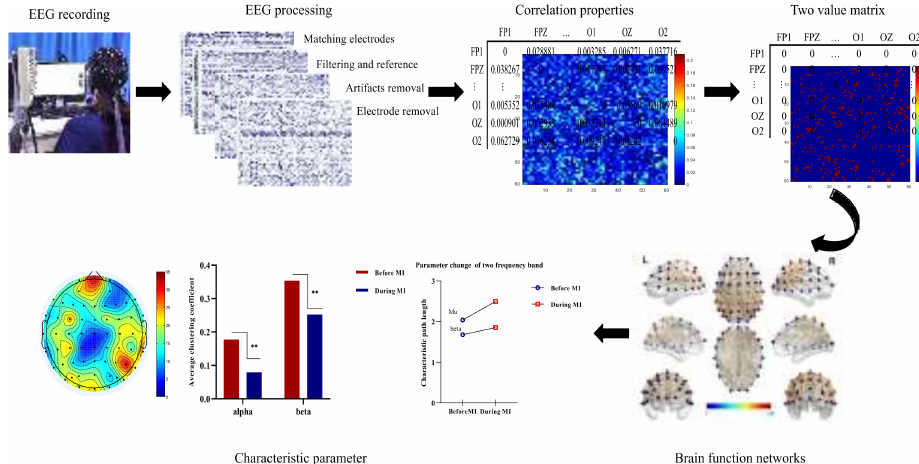
Figure 1. Overall research framework of this study.